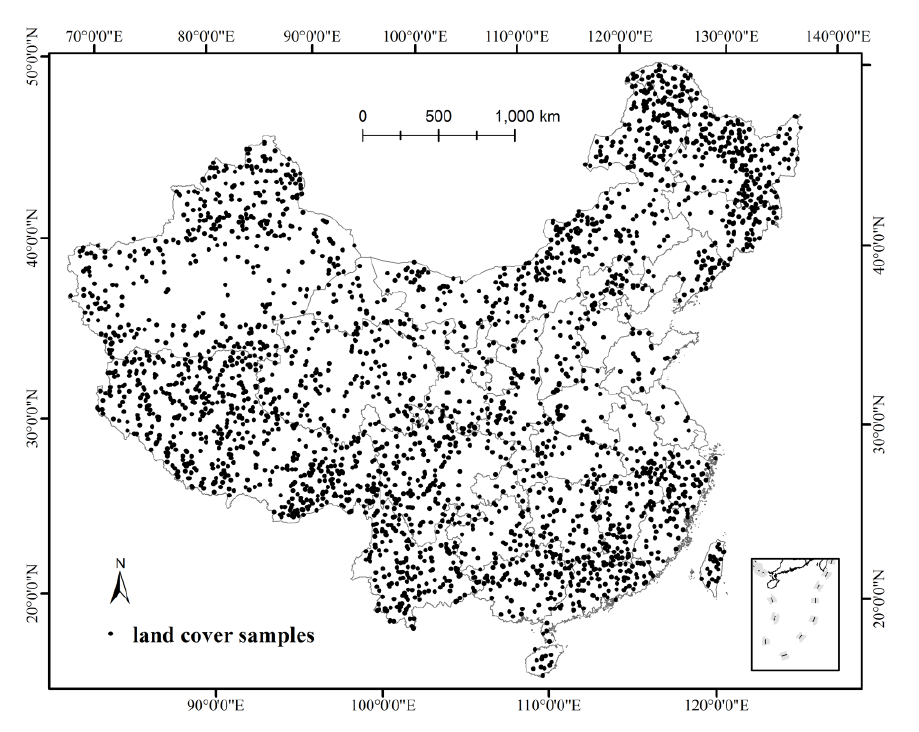
Figure 3. The distribution of land cover samples collected in